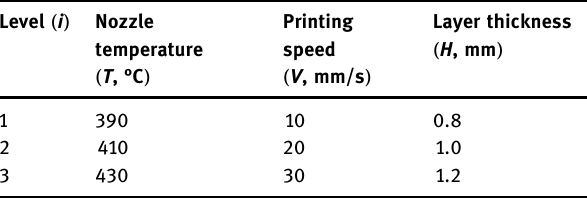
Table 2: Arrangement of the levels to the